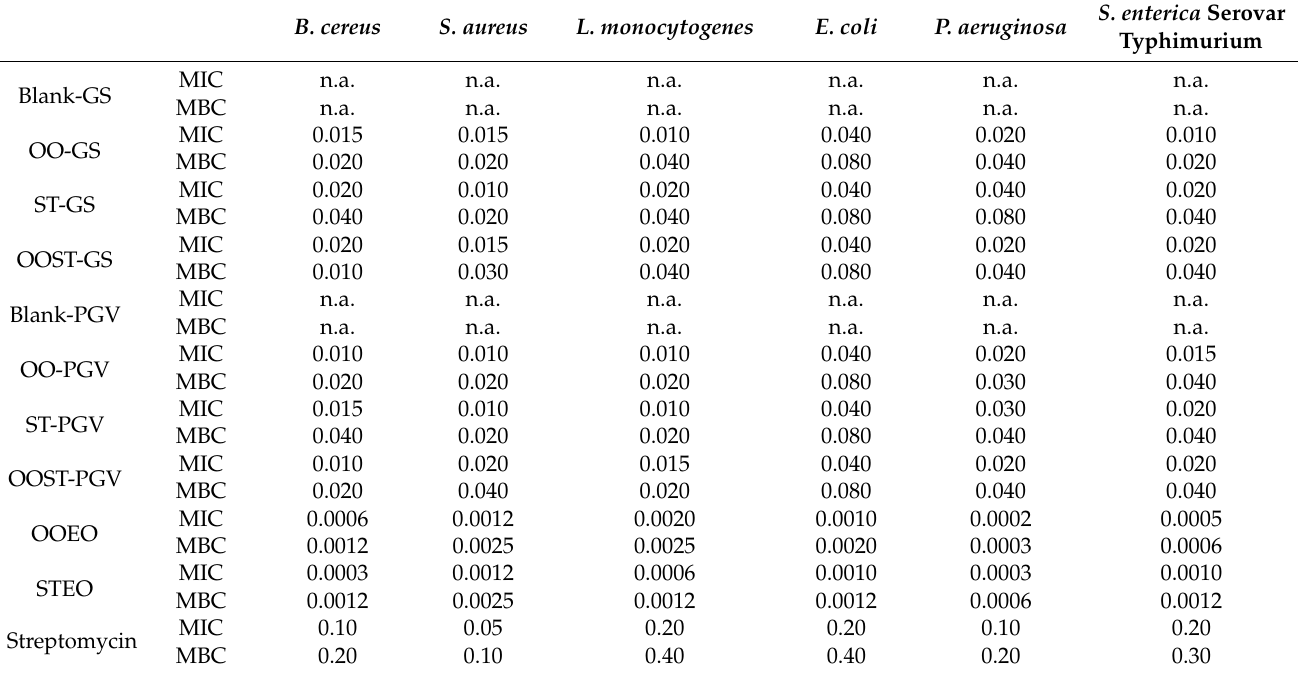
Table 5. Antibacterial activity (mg EO/mL medium) of pure and formulated EOs of O. onites (OOEO) and S. thymbra (STEO).